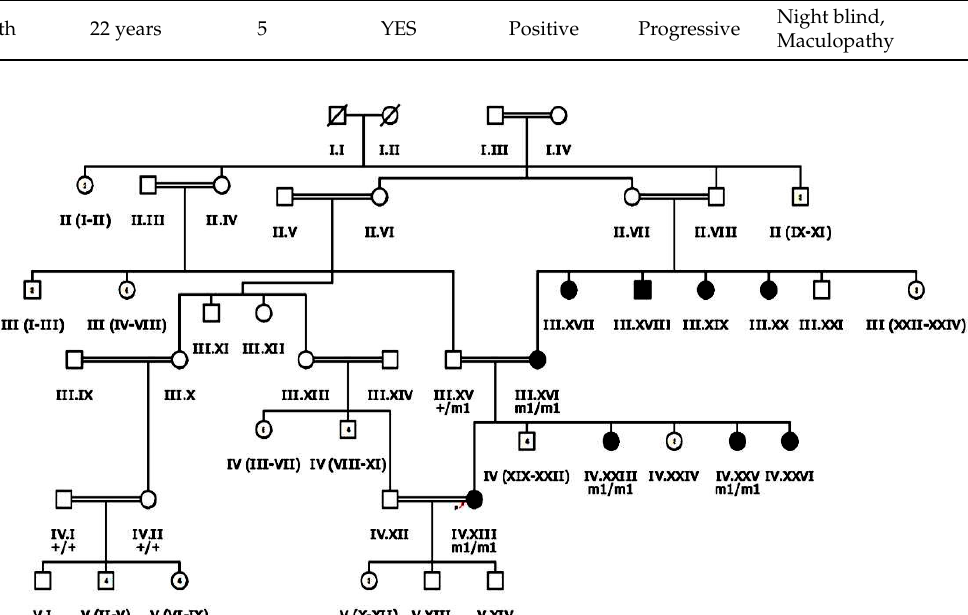
Figure 1. Pedigree drawing of inherited retinal dystrophy family, i.e., RP107 showing autosomal recessive pattern of phenotype in which the novel disease-causing variant in the EYS gene was detected. Squares and circles denote males and females, respectively. Filled symbols show affected, while unfilled symbols show unaffected individuals. Double lines indicate consanguineous union. M1/m1 refers to the homozygous disease-causing variant, whereas m1/+ and +/+ refers to heterozygous carrier and homozygous normal status, respectively.